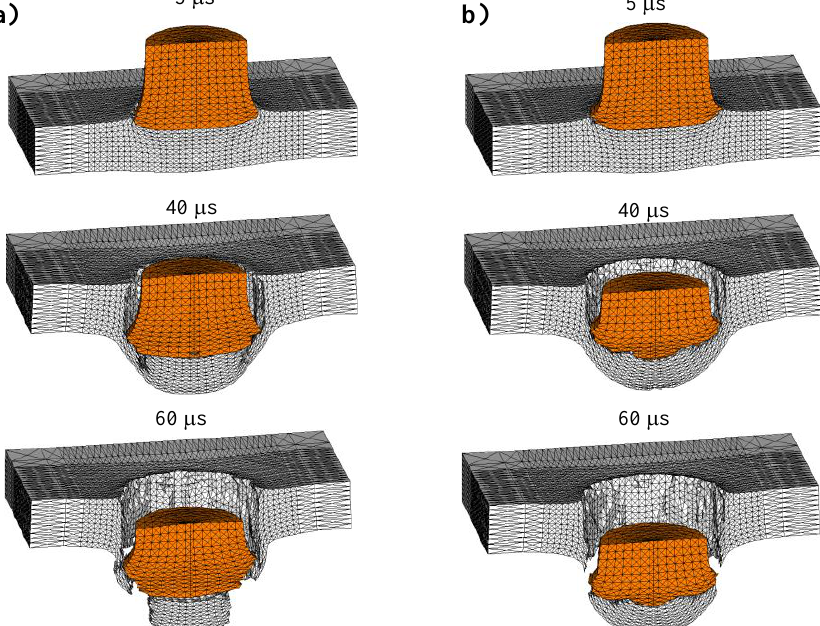
Fig. 5. FEM-based simulation results of interaction of the Ni hardening of the Ni Al alloy is defined by a) monotonically increasing  dependence, b) non- 3 monotonic 